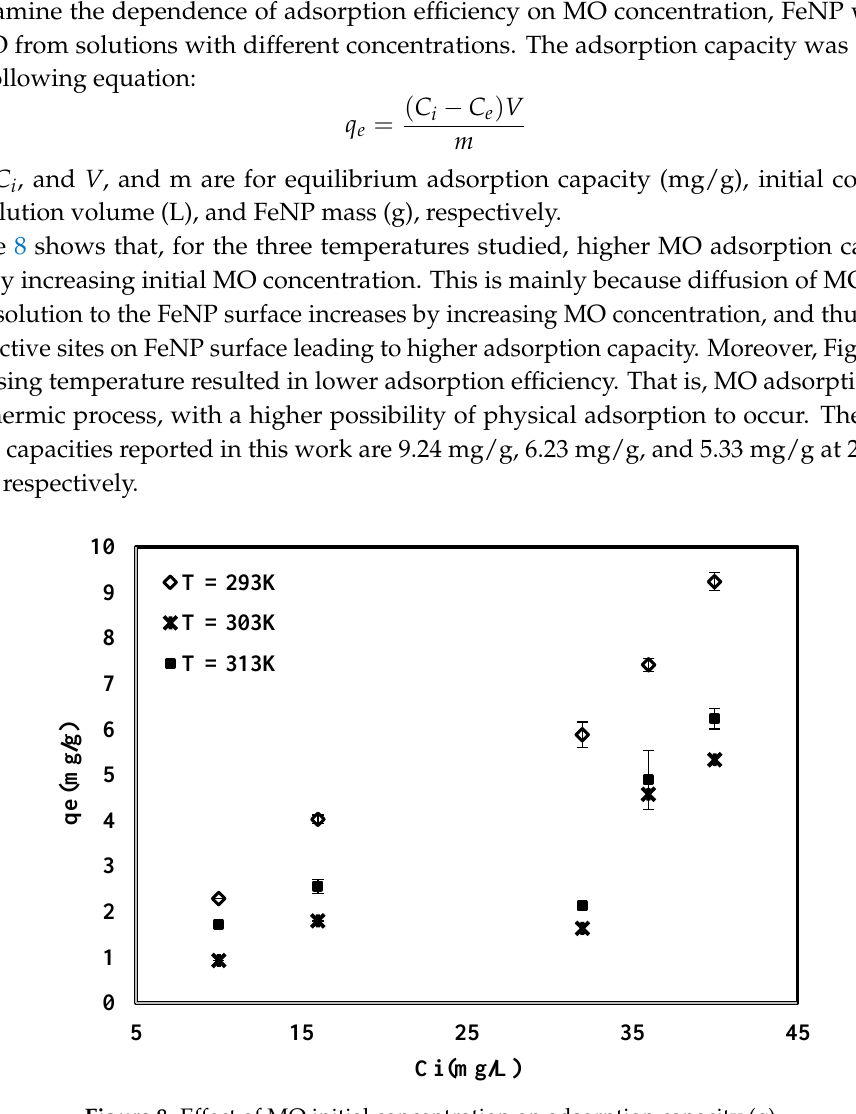
Figure 8. Effect of MO initial concentration on adsorption capacity (q).